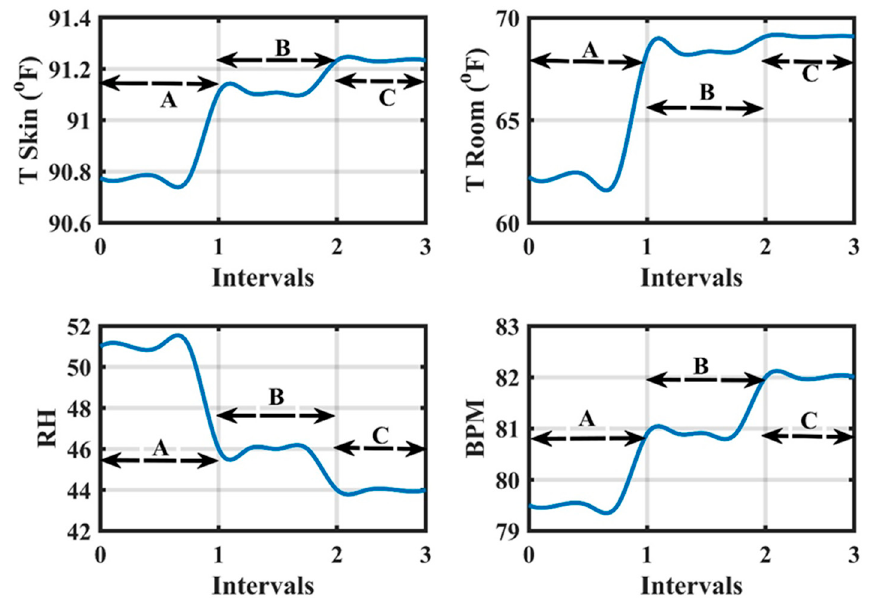
Figure 14. Skin temperature, room temperature, relative humidity, and BPM of phases A, B, and C. In phase B, a closed-loop feedback control system was used to achieve the required thermal CL for the consumer body. In this phase, the consumer was also at rest condition. 52%, respectively. The closed-loop system increased the operating temperature by 68.4 ◦ F